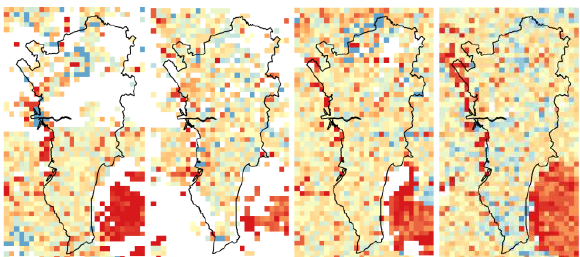
Figure 16. Sample PM 10 estimation maps using the best wet model for July 2017 to 2020.